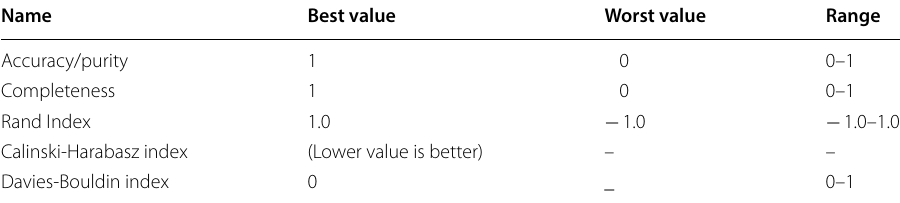
Table 4 The best and worst values and the range of each metric